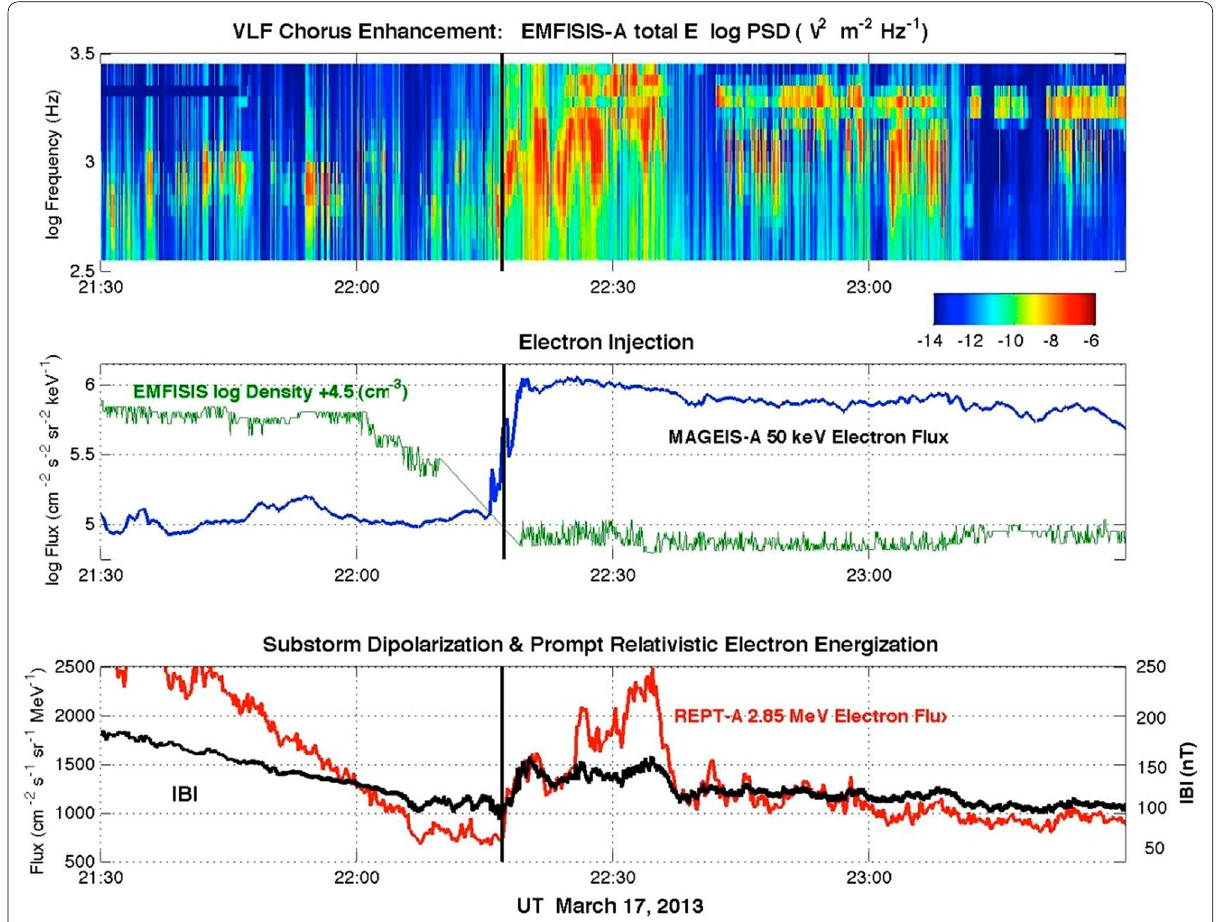
Fig. 4 a Total electric field power spectral density at VLF chorus band frequencies as observed with the EMFISIS instrument on RBSP-A. b Total chorus band wave power between 300 and 3000 Hz and MagEIS 50 keV electron flux (blue curve). c EMFISIS magnetic field magnitude (heavy curve) overplotted on REPT-A 2.85 MeV electron flux observations (red curve) ( Adapted from Foster et al.